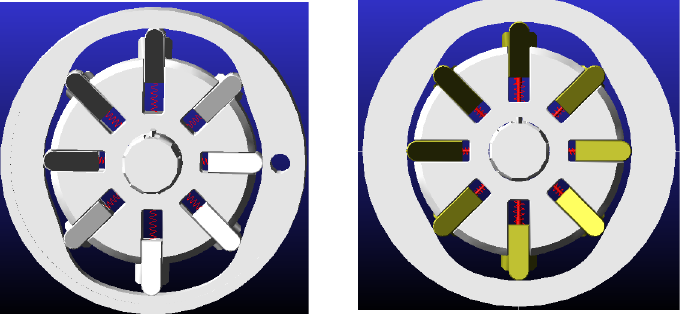
Figure 8. ADAMS model of sliding vane pump.